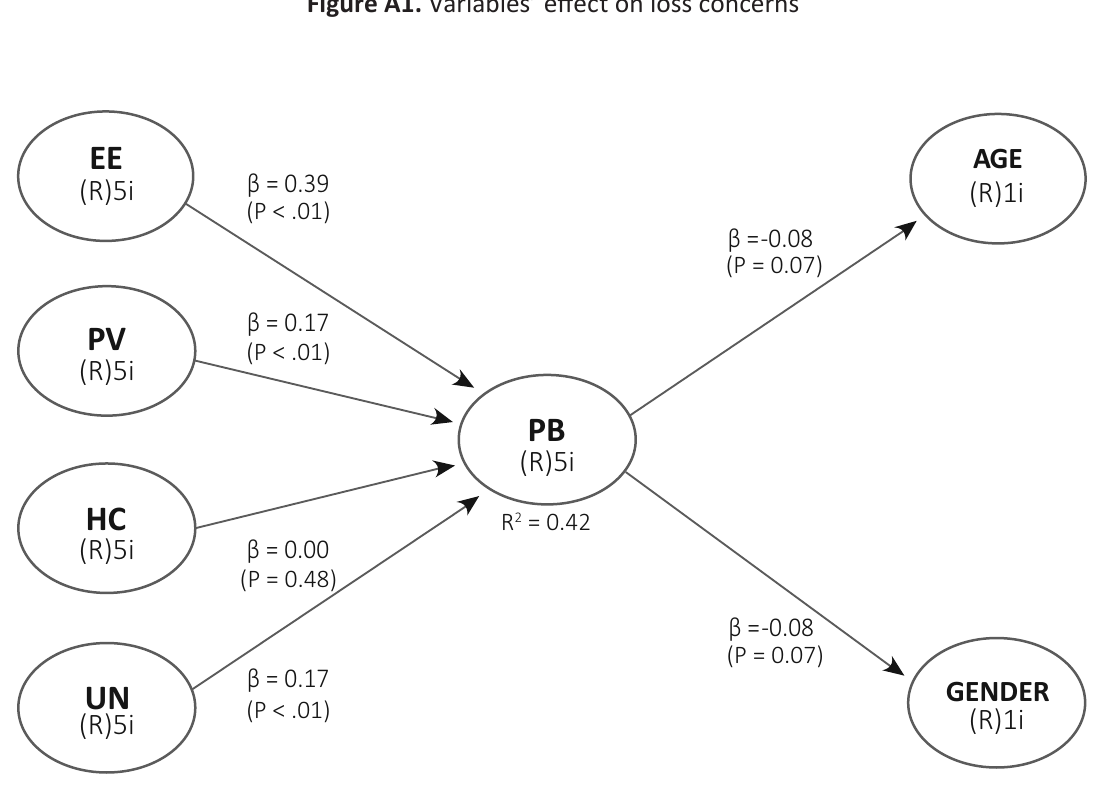
Figure A1. Variables’ effect on loss concerns